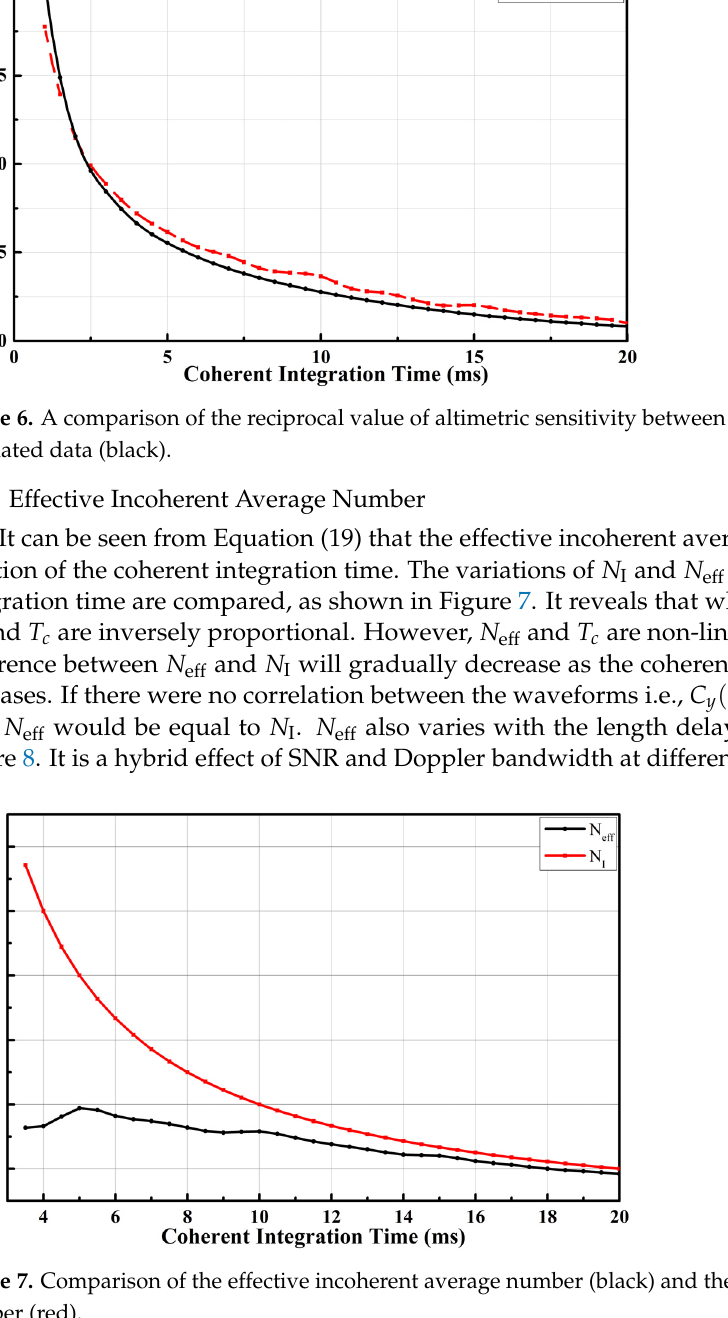
Figure 7. Comparison of the effective incoherent average number (black) and the incoherent average number (red).